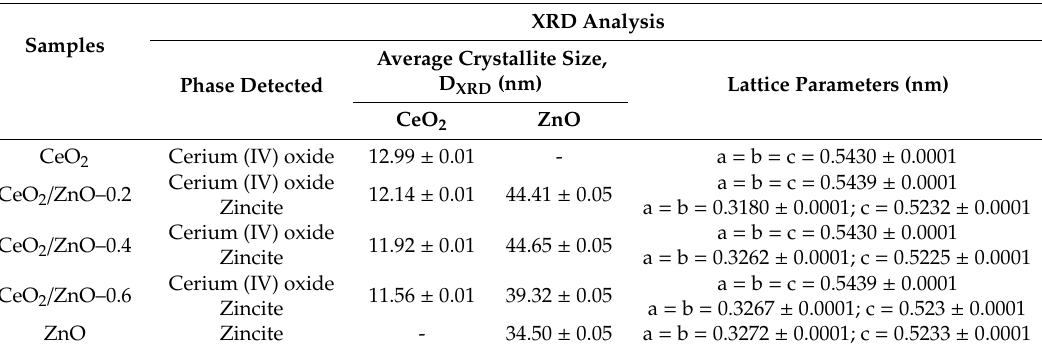
Figure 2. XRD patterns of CeO 2 , ZnO and the CeO 2 / ZnO samples. Table 2. Structural characteristics of CeO 2 , ZnO and the CeO 2 / ZnO samples.